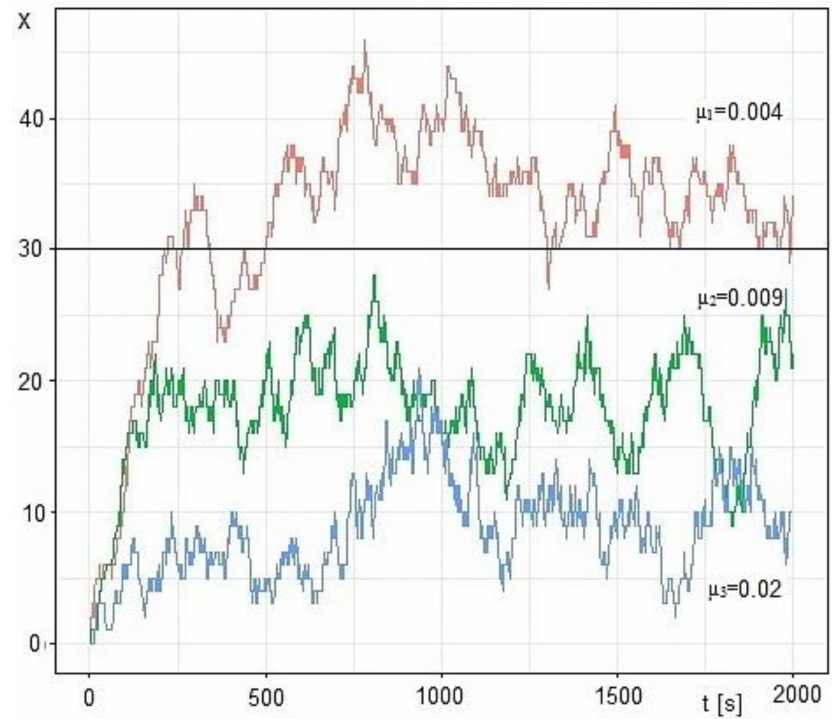
Figure 2. Simulation of transition between states in consecutive moments of time t = 2000 (starting from state 0—no pending reports), for µ 1 = 0.004, µ 2 = 0.009 and µ 3 = 0.02, λ = 0.05. In Figure 1, successive moments of time are marked on the OX axis. The status, i.e., the number of notifications at the current moment, is marked on the OY axis. The